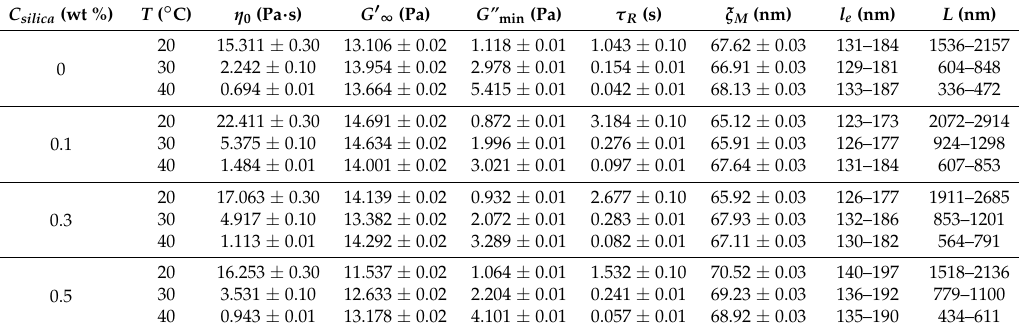
Table 1. The rheological parameters of NEWMS with different mass fractions of silica nanoparticles at different temperatures.